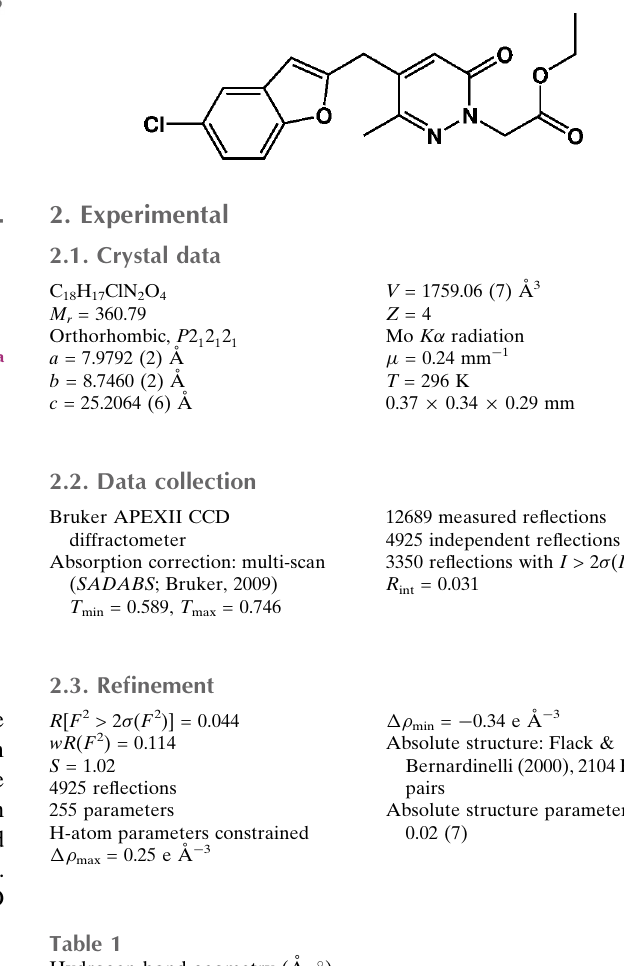
Hydrogen-bond geometry (A˚ , (cid:2)